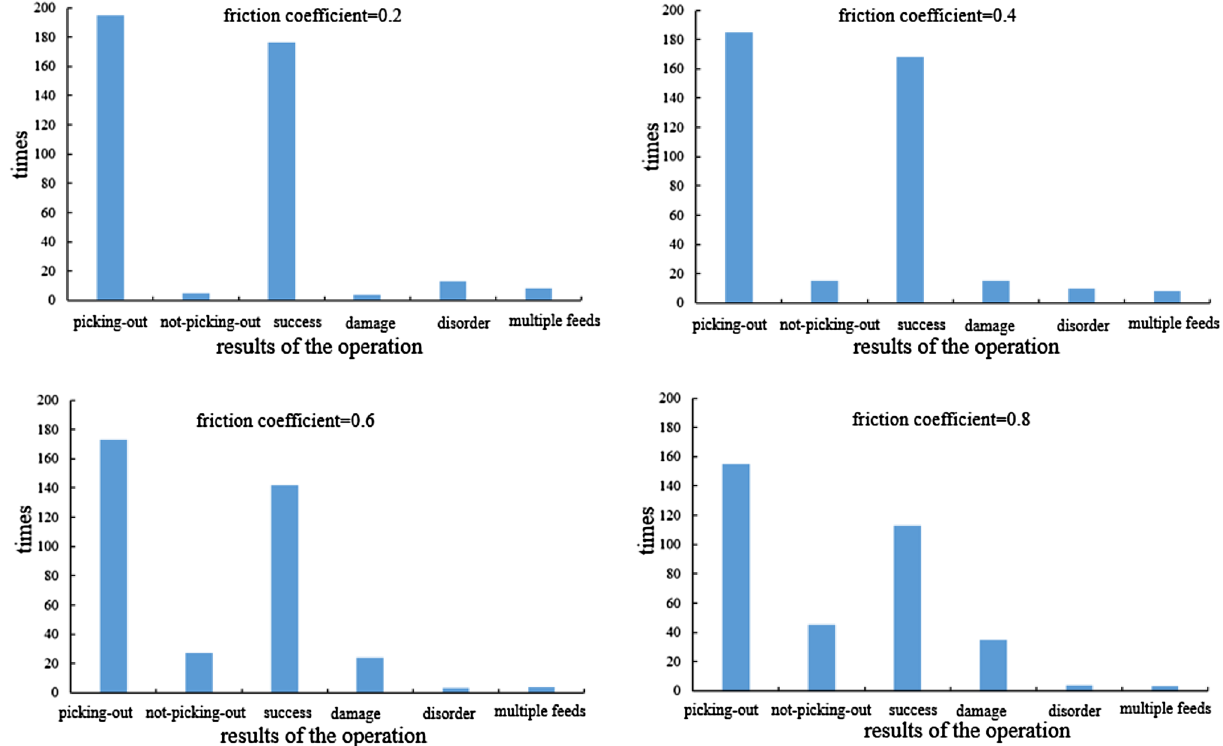
Fig. 13 Results of the operation when the dynamic friction coefficients